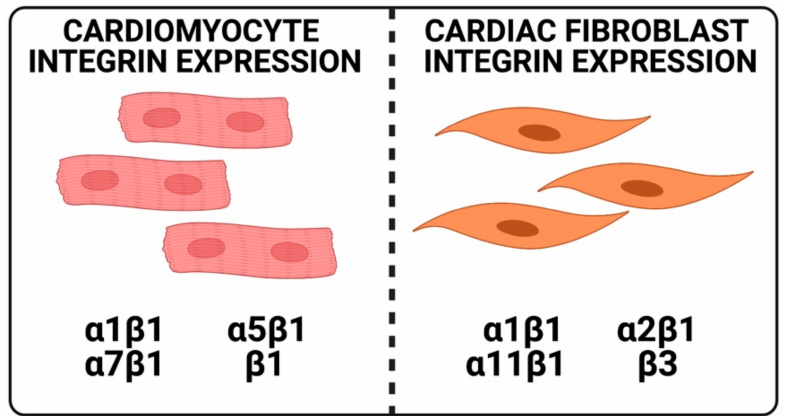
Figure 1. Integrin expression in healthy adult cardiomyocyte and cardiac fibroblast. In the healthy heart, adult cardiomyocytes have been shown to express α 1 β 1, α 5 β 1, α 7 β 1, and β 1 integrins. In the adult fibroblast, integrins have been shown to express α 1 β 1, α 2 β 1, α 11 β 1, and β 3 integrins. These integrins bind to a variety of ligands and ECM components. α 1 β 1, α 2 β 1,